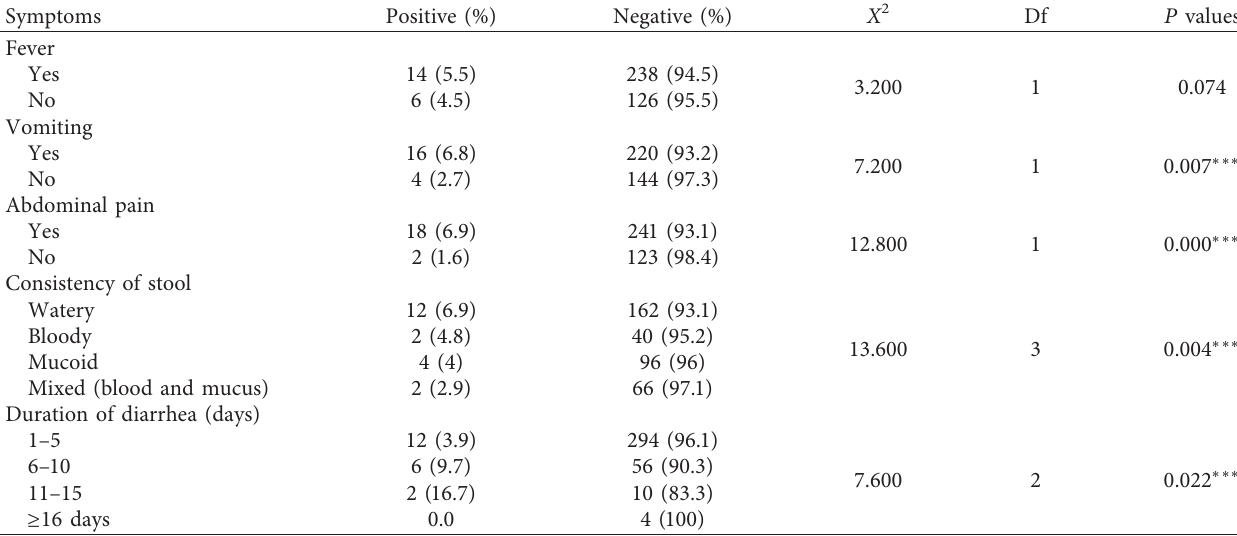
Table 3: Associations of Salmonella infection and clinical features in diarrheal patients.